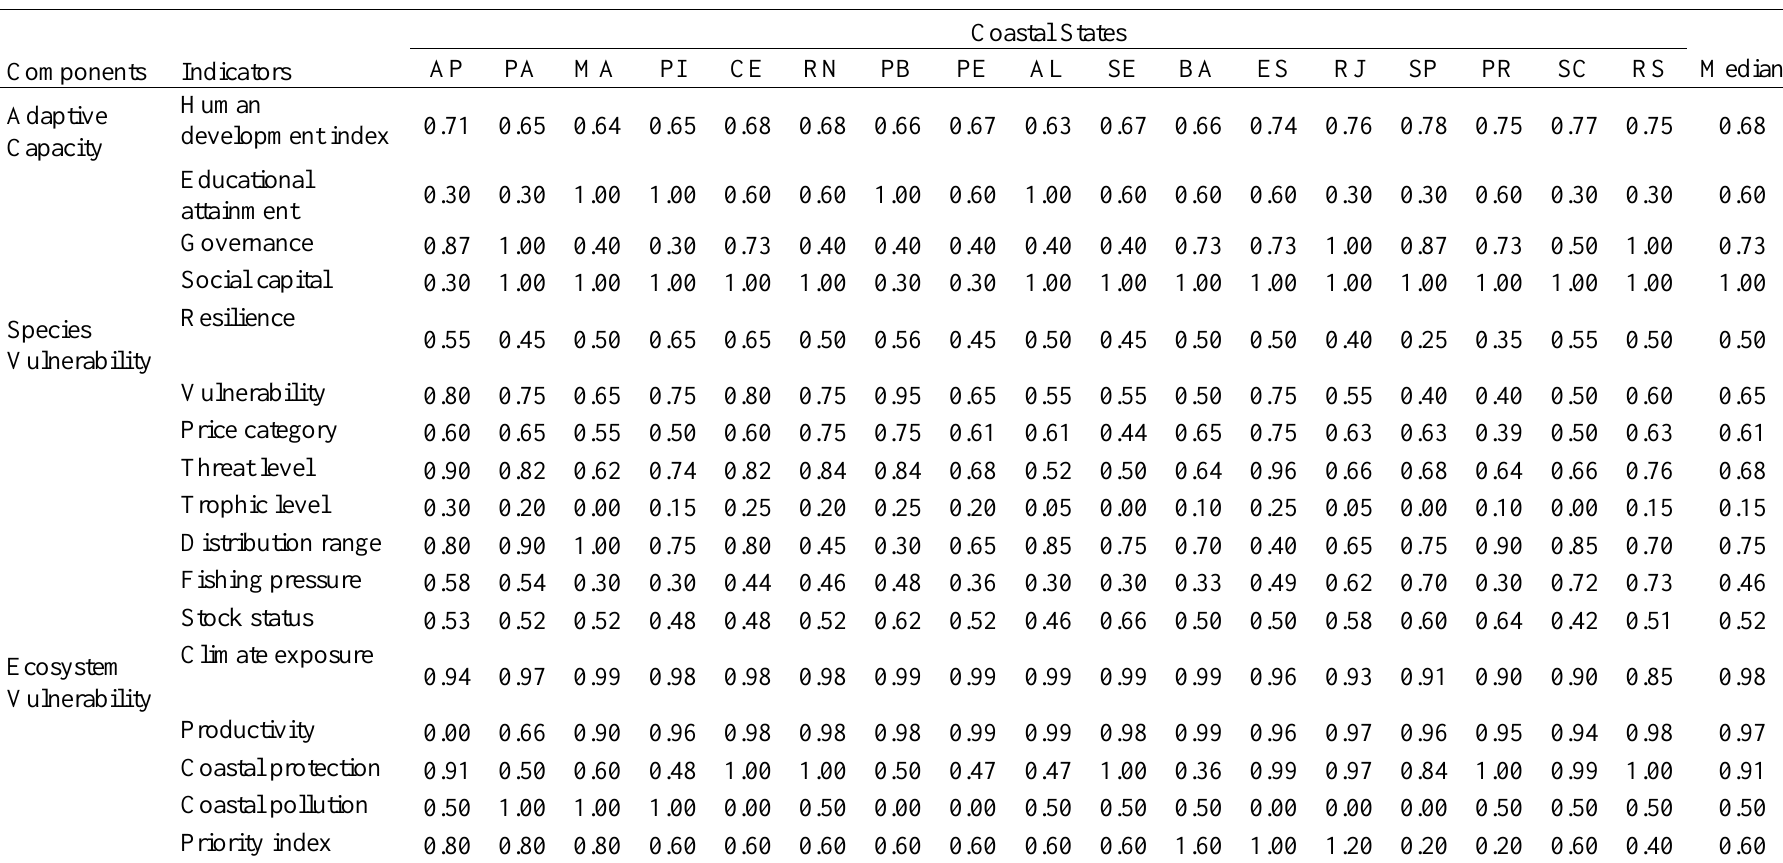
Table A5.1: Indicator scores for the three components in all 17 Brazilian coastal states.